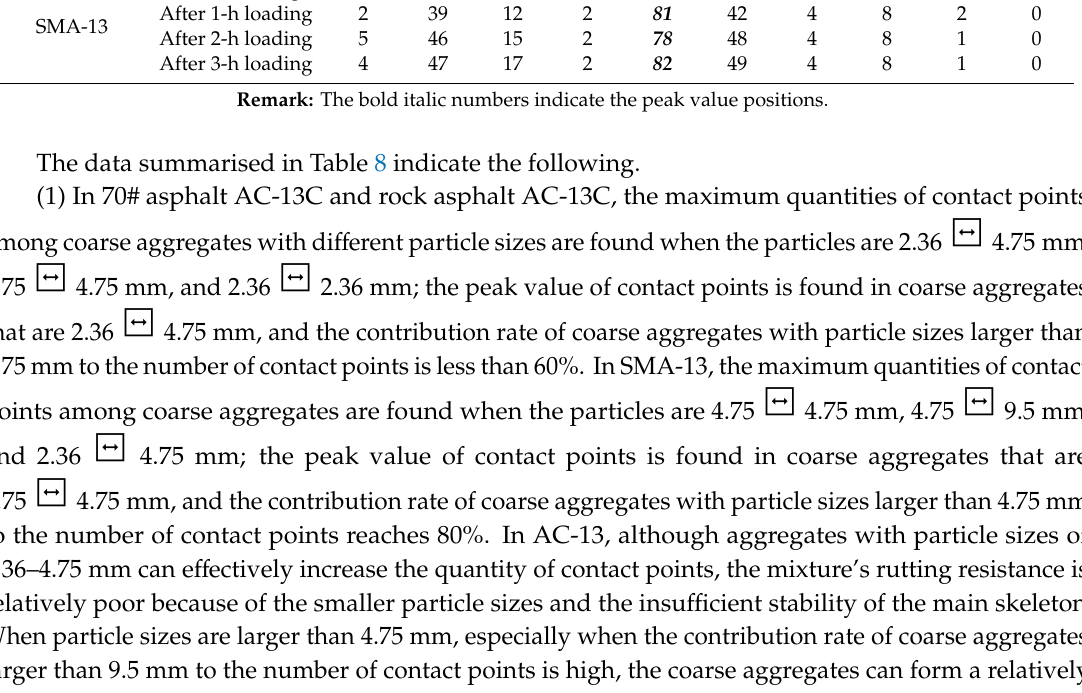
Table 8. Contact distribution of coarse aggregates at different loading stages.